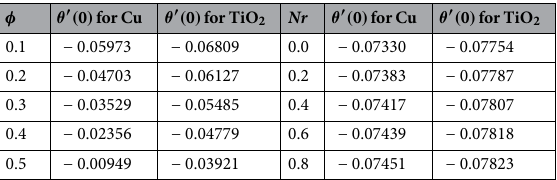
Table 6. Effect of φ and Nr on heat transfer rates for Cu and TiO 2